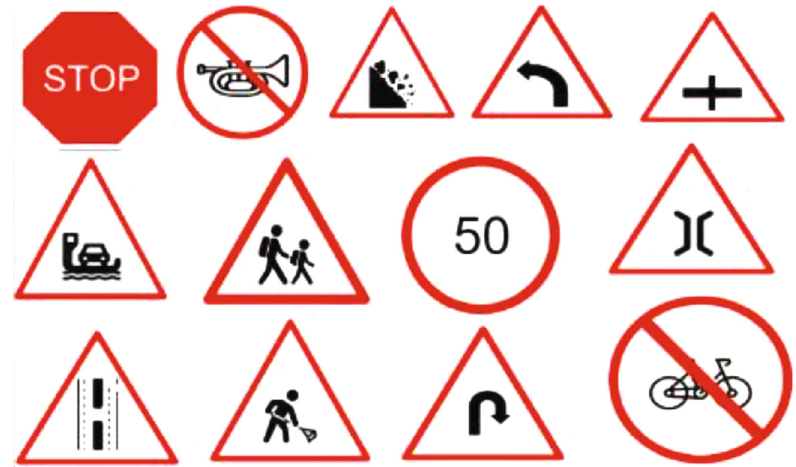
Figure 1: Tra ffi c indications [1]. Source: https://civilnoteppt.com/tra ffi